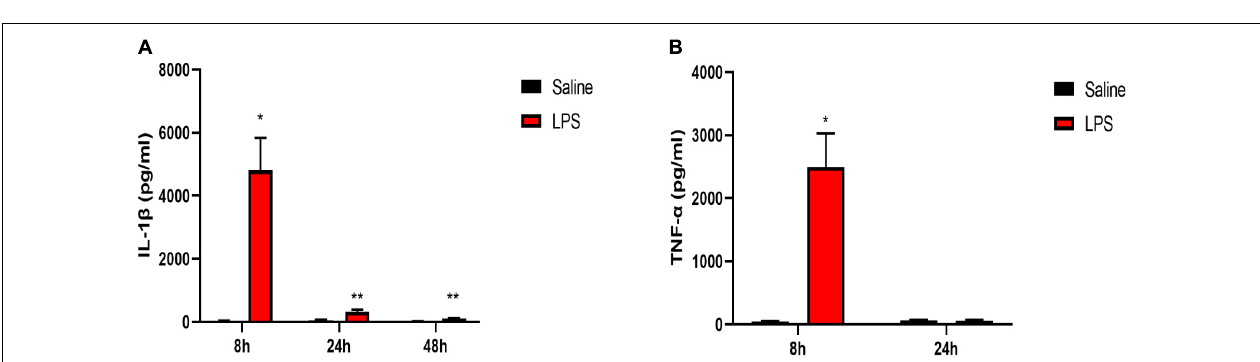
FIGURE 2 | LPS induced increased levels of pro-inflammatory cytokines in serum. (A) Serum level of IL-1 β was elevated 8, 24, and 48 h after LPS injection in neonatal rats. (B) Serum level of TNF- α was elevated 8 h after LPS injection in neonatal rats. Results are expressed as the mean ± SEM, n = 4–5 animals for each group, and were analyzed by unpaired t -test. * P < 0.05, ** P < 0.01 LPS group vs. Saline